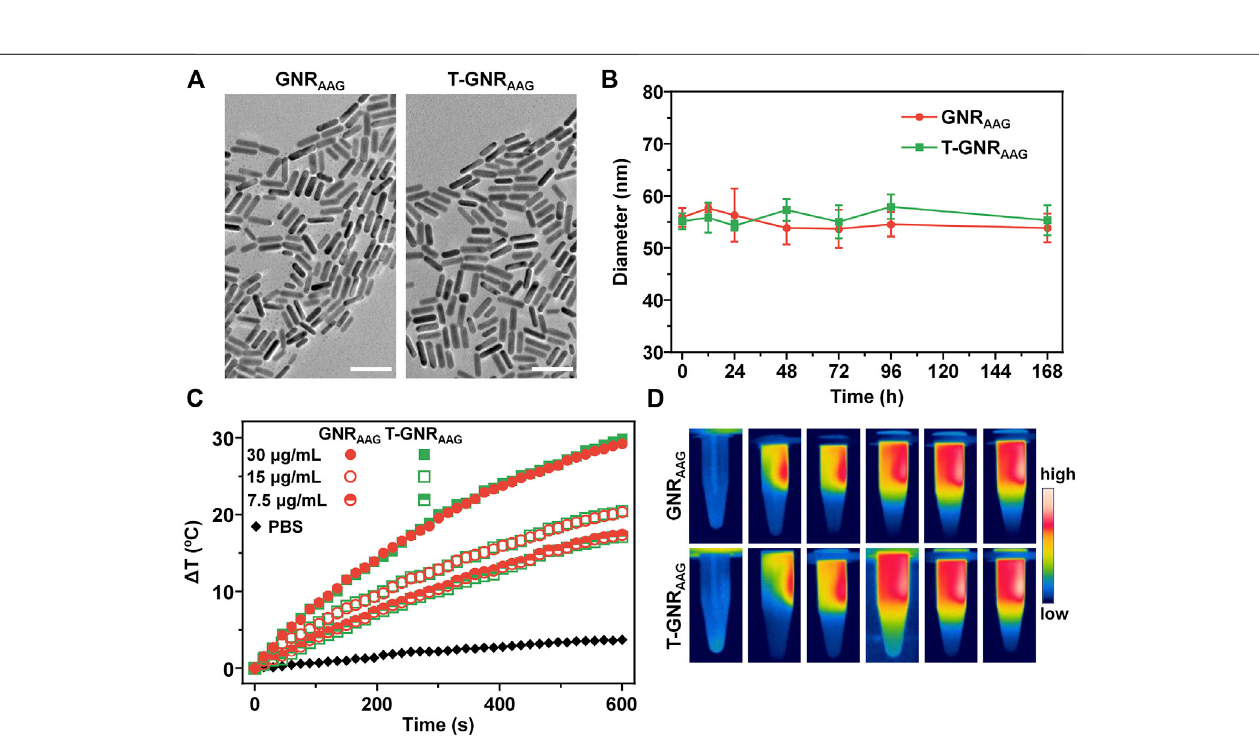
FIGURE 2 | (A) Transmission electron microscope of GNR AAG and T-GNR AAG . The scale bar is 50 µm. (B) Change of hydrodynamic size in PBS solution (10 mM, pH 7.4). (C) Temperature change curves of GNR AAG and T-GNR AAG under 808 nm laser irradiation (1.0 W/cm 2 ) at different concentrations. (D) IR thermal images of GNR AAG and T-GNR AAG (30 μ g/ml) under laser irradiation (808 nm, 1.0 W/cm 2 ).